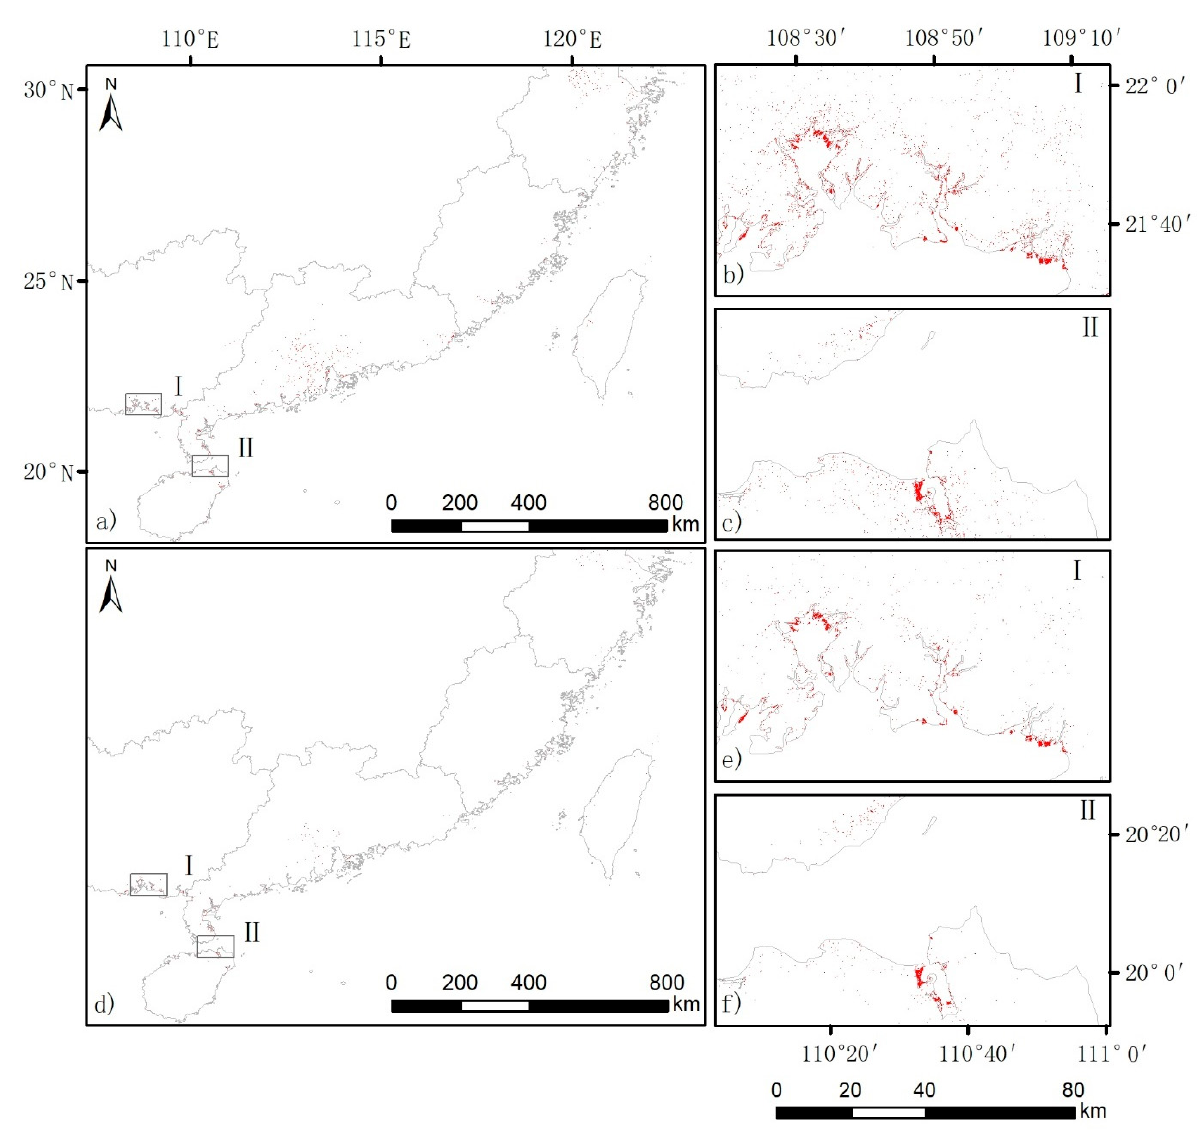
Figure 6. Mangrove classification results in China in 2018 from the two classification schemes: ( a ) the standard scheme and ( d ) the new scheme in the first experiment. The results were mapped directly without corrections. Because the mangroves cover a very small portion of the coastal area, the distribution of the classification results are mainly visible in the zoomed-in figures ( b ), ( c ), ( e ), and ( f ), which share the same scale bar. Table 4. Confusion matrices of the classifications without correction with a standard classification scheme and a new classification scheme in the first experiment. The performance of classification with the standard scheme is shown in ( a ), and that with the new scheme is shown in ( b ).